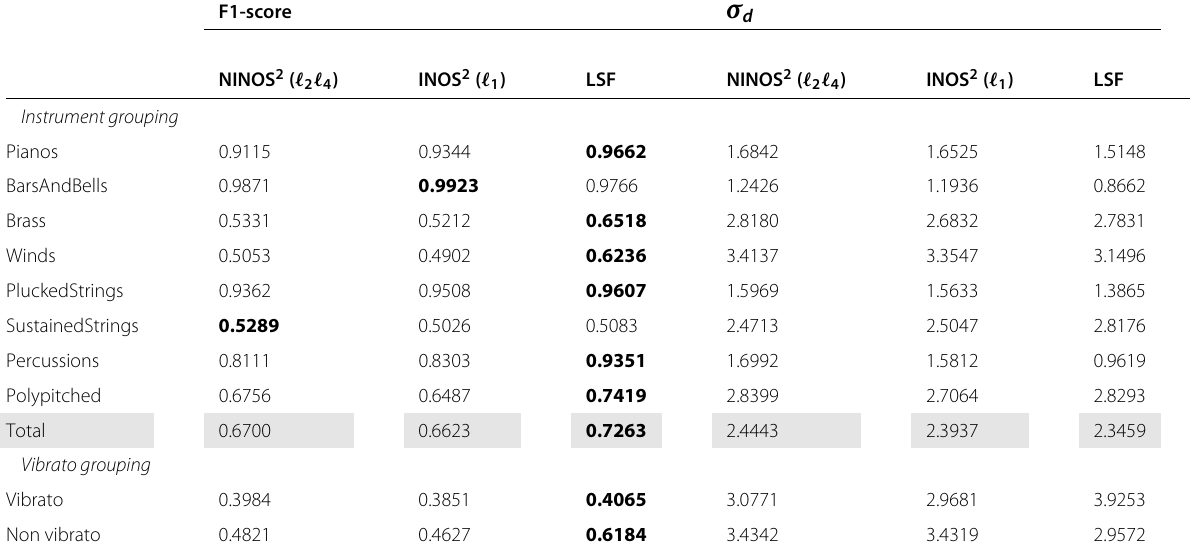
Table 2 NOD performance measures for M